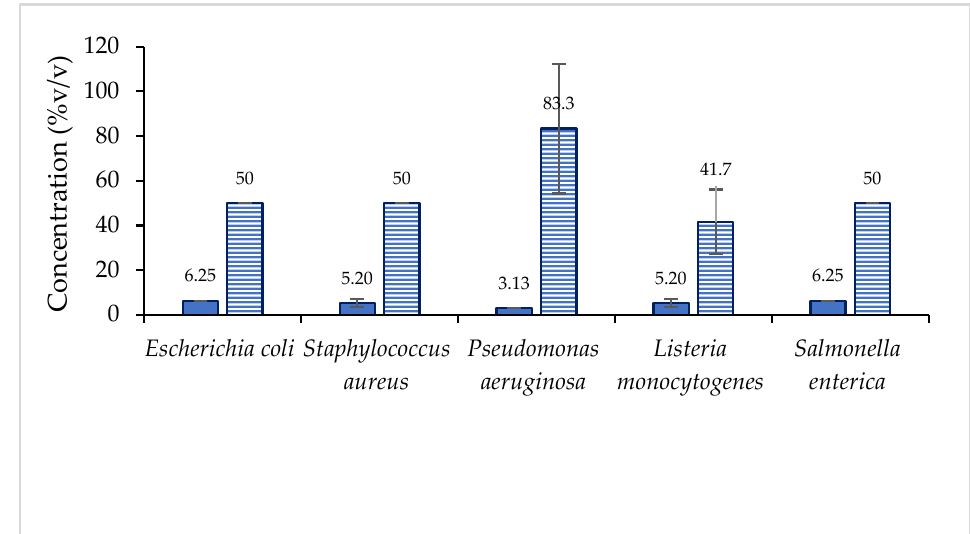
Figure 3. Minimum inhibition concentration of vinegar samples prepared from fresh (solid bar) and dried (line bar) jaboticaba berries.